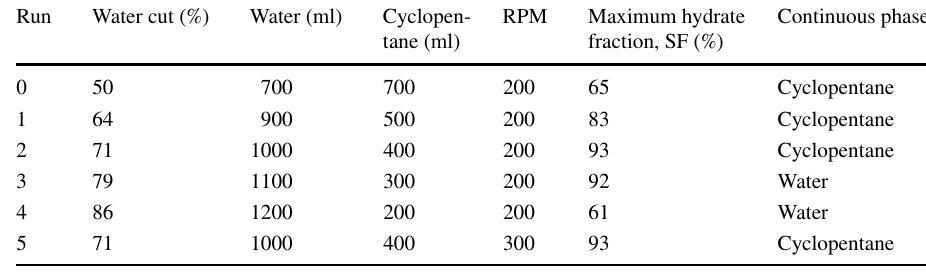
Fig. 2 Torque response during cyclopentane hydrate formation. W.C watercut, SF solid